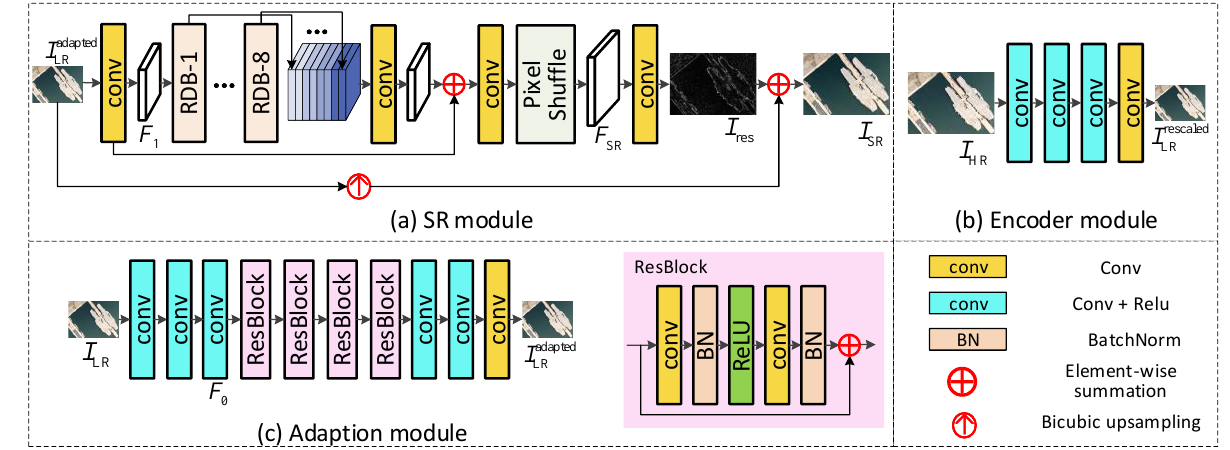
Figure 2. The structure of each module in our proposed